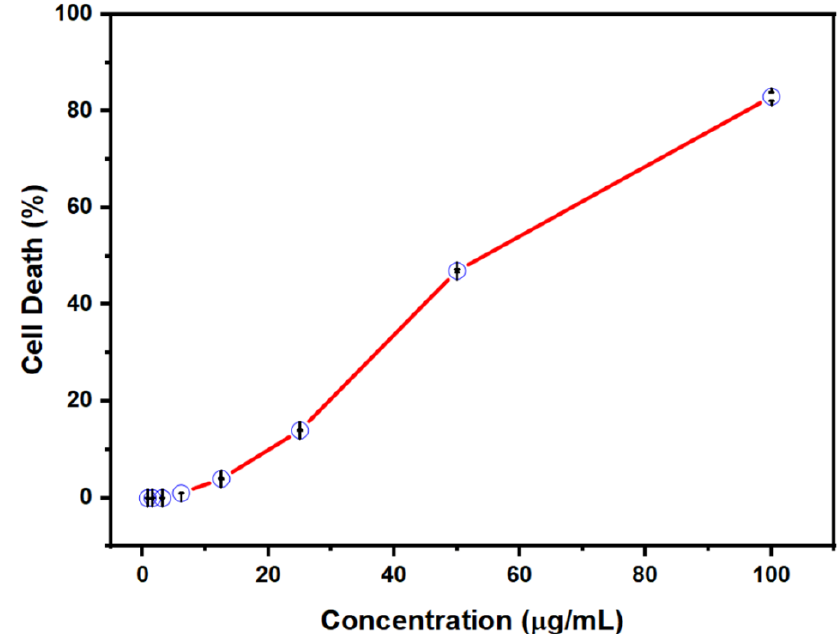
Figure 6. Cell death percentage at different β -Ni(OH) 2 concentrations.